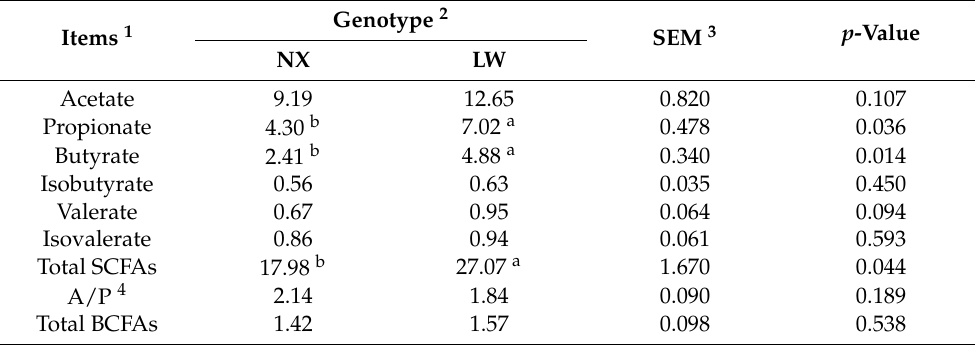
Table 2. Concentrations of short-chain fatty acids (SCFAs) in the cecal digesta in Ningxiang pig and Large White pig.